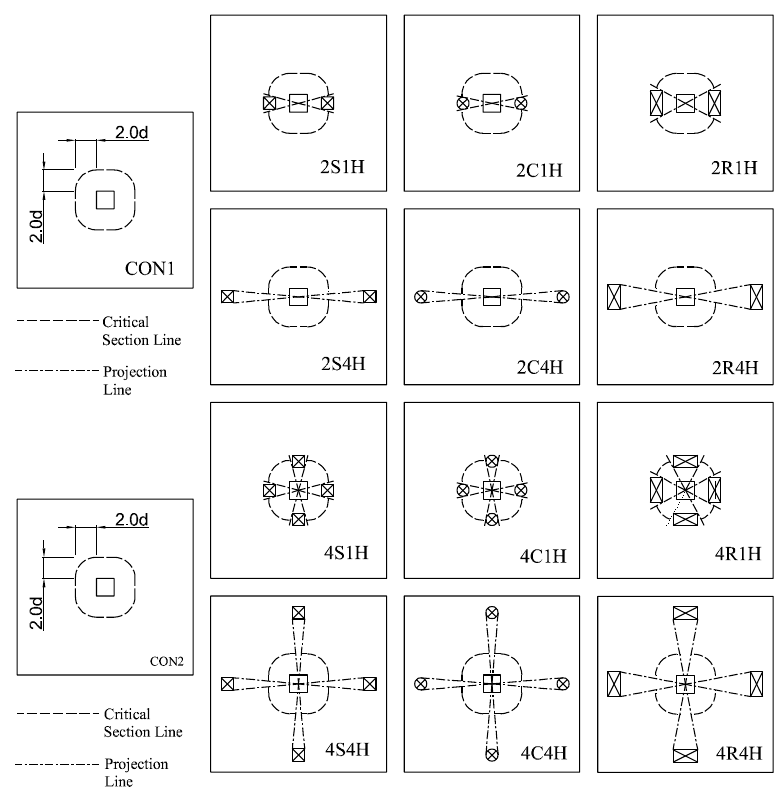
Figure 18. Definition of critical perimeter as per Eurocode 2. Table 4. Comparison between experimental and analytical punching shear strengths.